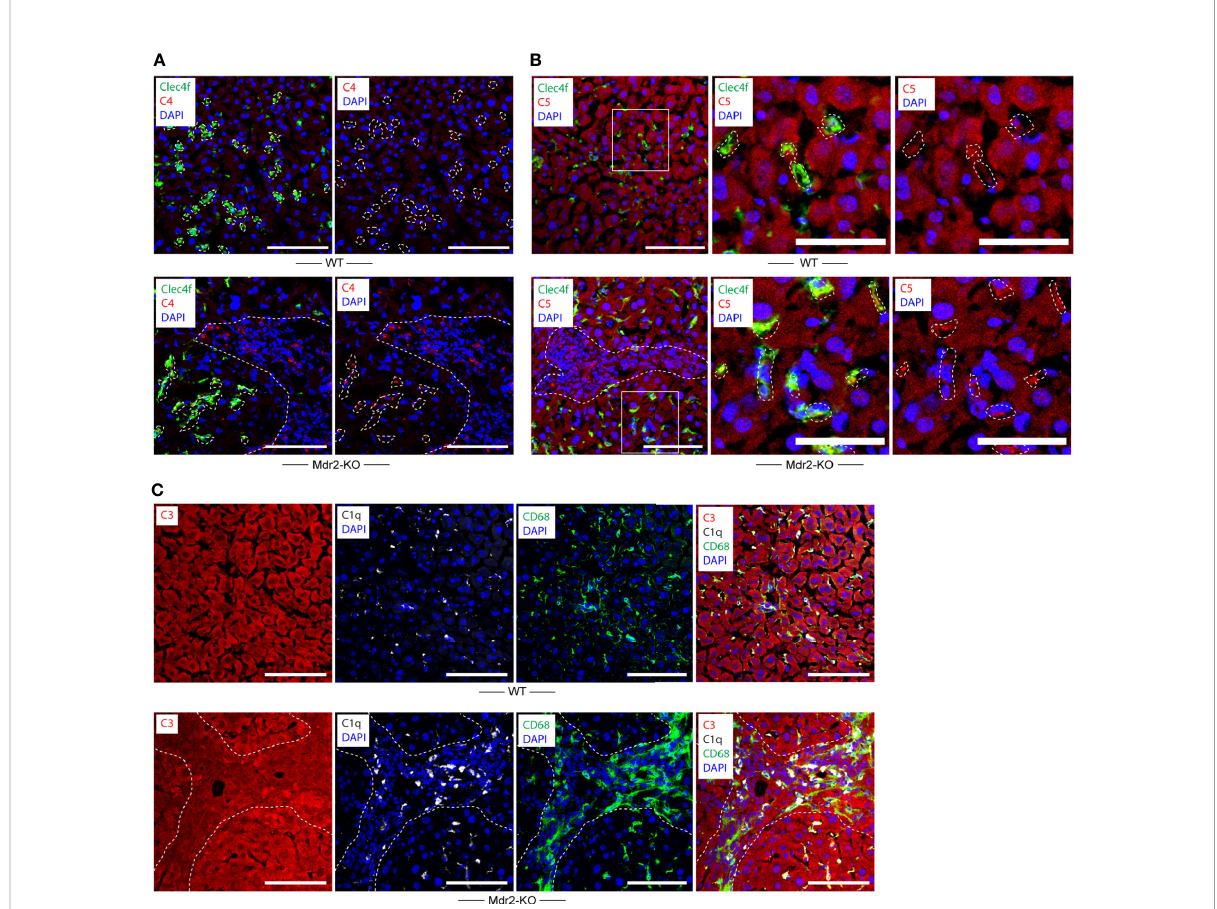
FIGURE 3 Complement component C4 and C5 expression in WT and Mdr2-KO mouse livers. (A) Liver sections were stained with Clec4f (green) for KCs, C4 (red), and DAPI for nuclei (blue). Dotted lines demarcate Clecf + cells as well as immune cell in fi ltrates in portal triads from adjacent liver parenchyma. (B) Liver sections were stained with Clec4f (green) for KCs, C5 (red), and DAPI (blue) for nuclei. (C) Complement component C3, C1q, CD68 expression in WT and Mdr2-KO livers. Liver sections were stained with C3 (red), C1q (white), and CD68 (green) for macrophages/KCs and DAPI for nuclei (blue). Dotted lines demarcate immune cell in fi ltration sites from adjacent liver parenchyma. White squares represent high magni fi cation images shown separately. Representative images of WT livers (n=6); Mdr2-KO livers (n=6) are shown. Scale bars 100 m m in images of low and high magni fi